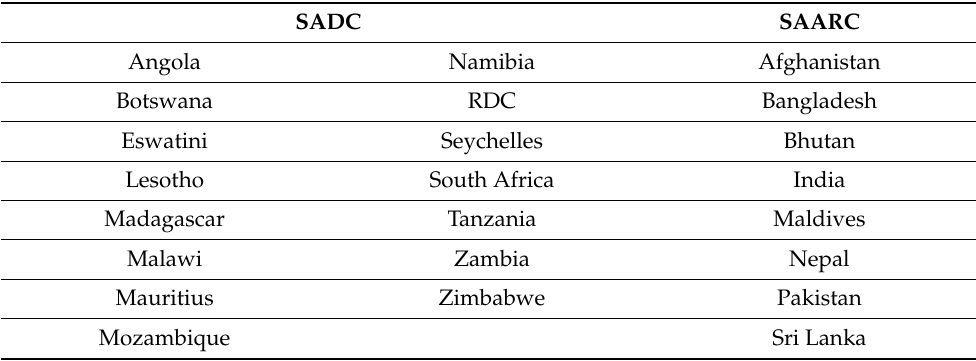
Table A1. Countries in the Sample.